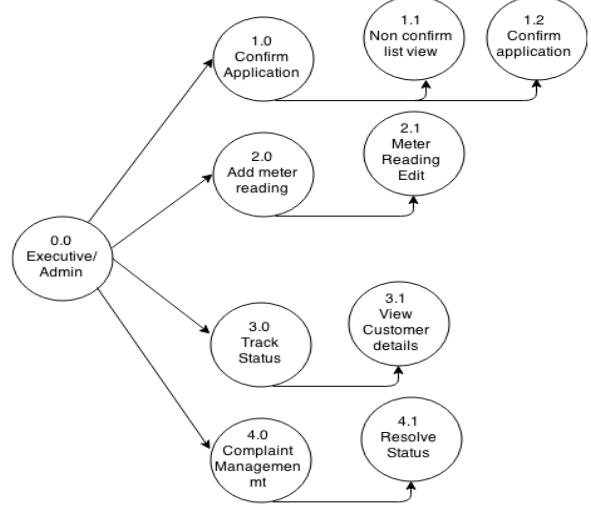
Figure 17. Level 2 DFD for Executive in the